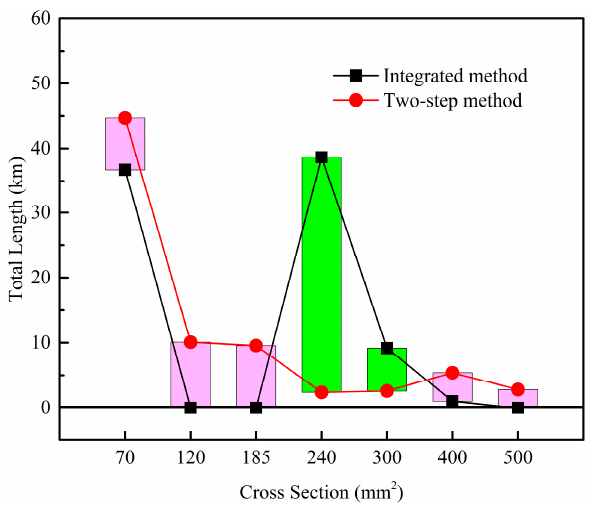
Figure 10. Comparison of lengths of different cross-sectional cables used in the topology.